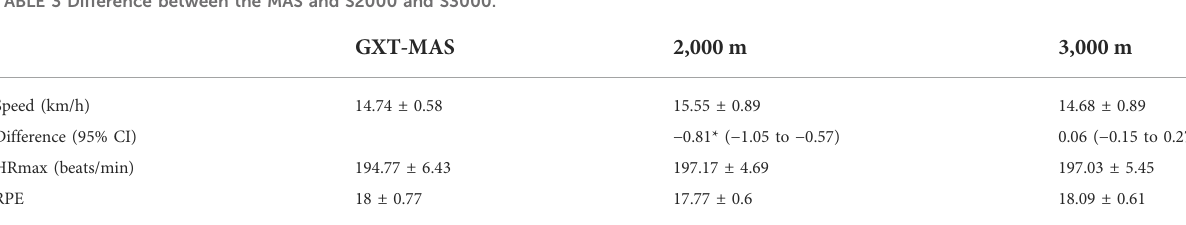
TABLE 3 Difference between the MAS and S2000 and